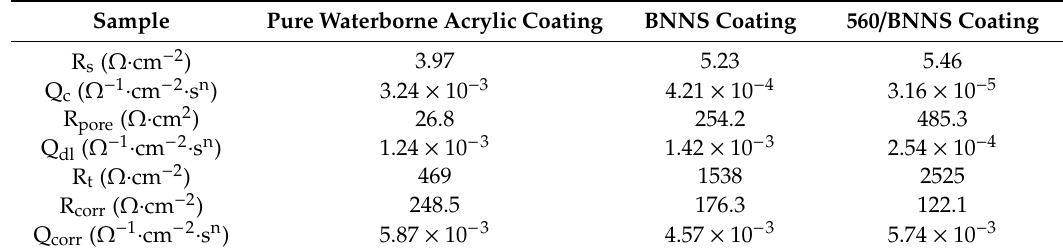
Table 3. EIS fitting parameters of long term immersion.